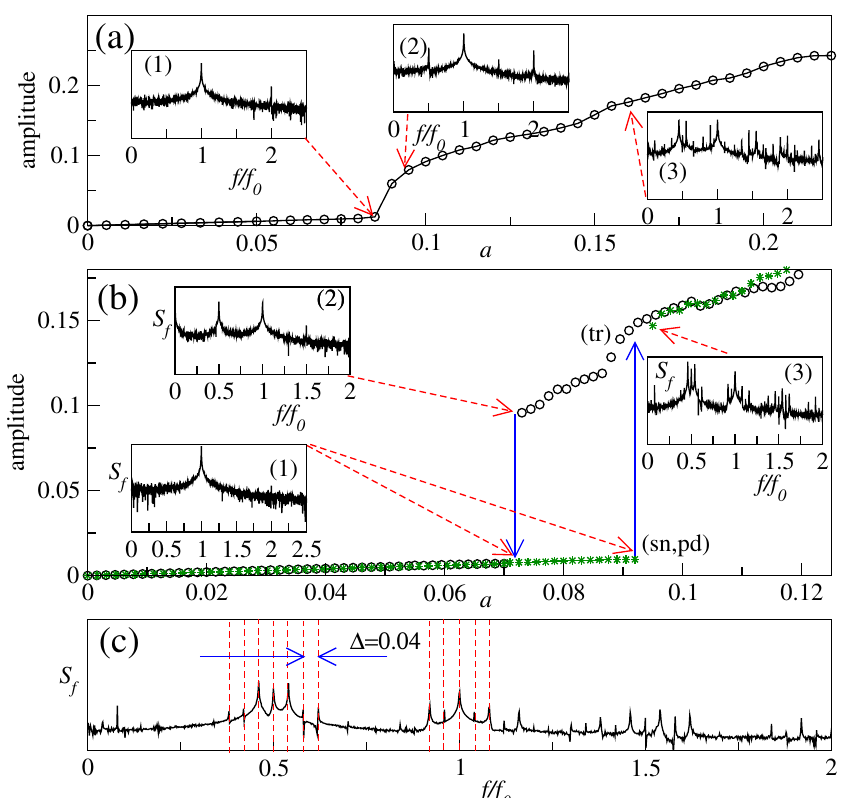
Figure 20. Average response amplitude of an ethanol drop vibrated at the frequencies ( a ) f =21 and ( b ) 28Hz as a function of the gradually increasing amplitude a . Harmonic waves lose their stability ( a ) via a supercritical period-doubling bifurcation (pd) at a = 0.08 and ( b ) via a torus bifurcation at a = 0.09. The modulational instability sets in via a torus bifurcation (tr) on the subharmonic branch. At f = 28Hz, one observes the formation of a hysteresis loop consisting of gradually increasing (asterisk) and gradually decreasing (circle) branches, where sn and tr correspond to the saddle-node and torus bifurcations, respectively. ( c ) Close-up of spectrum S f (3) in panel ( b ) in the regime of the developed modulational instability. The dashed vertical lines highlight the location of equally distant delta peaks with the scaled inter-peak distance of f / f 0 = ∆ =